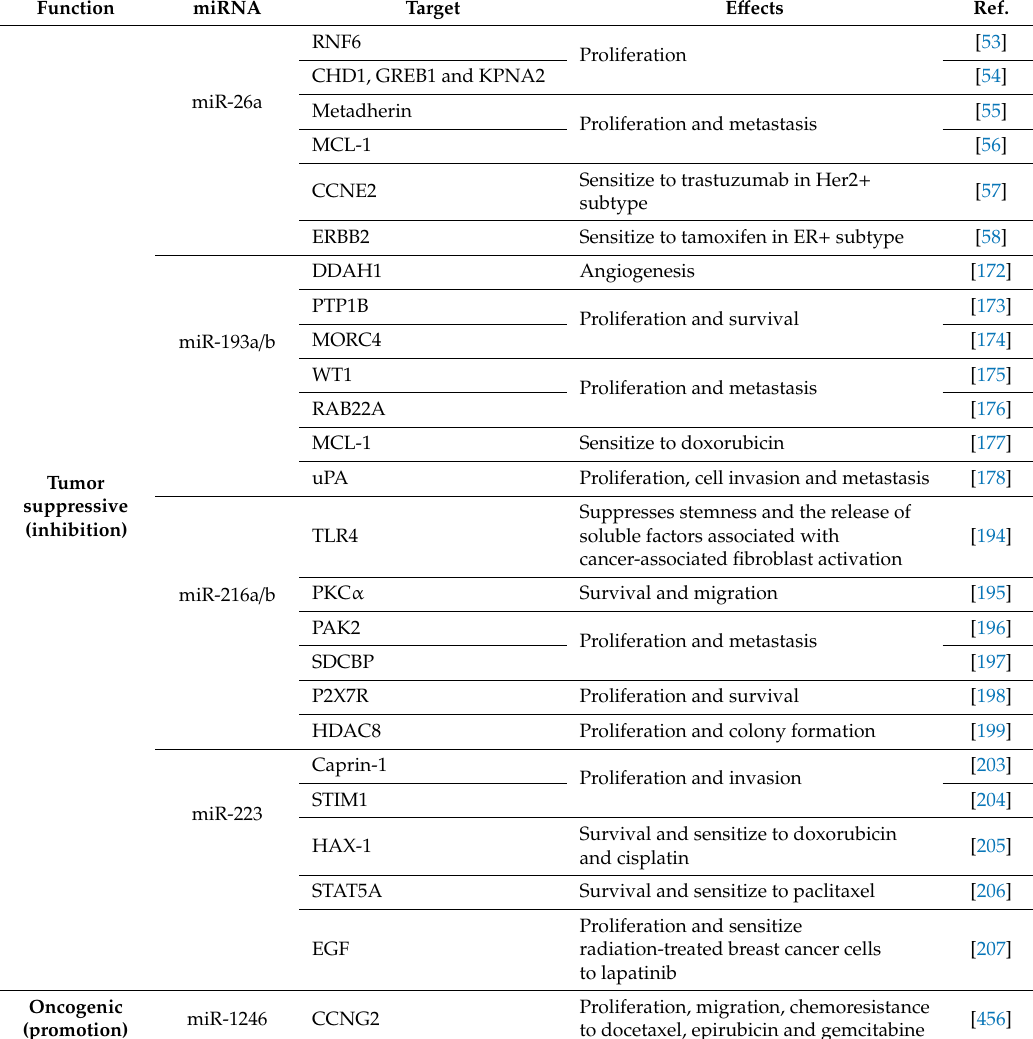
Table 1. Binding partners of miRNAs in regulating